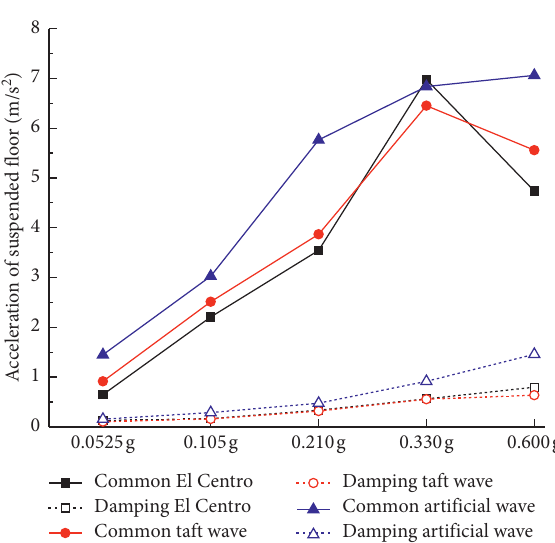
Figure 9: Peak acceleration response of the top suspended floor at 500m/s apparent wave velocity.